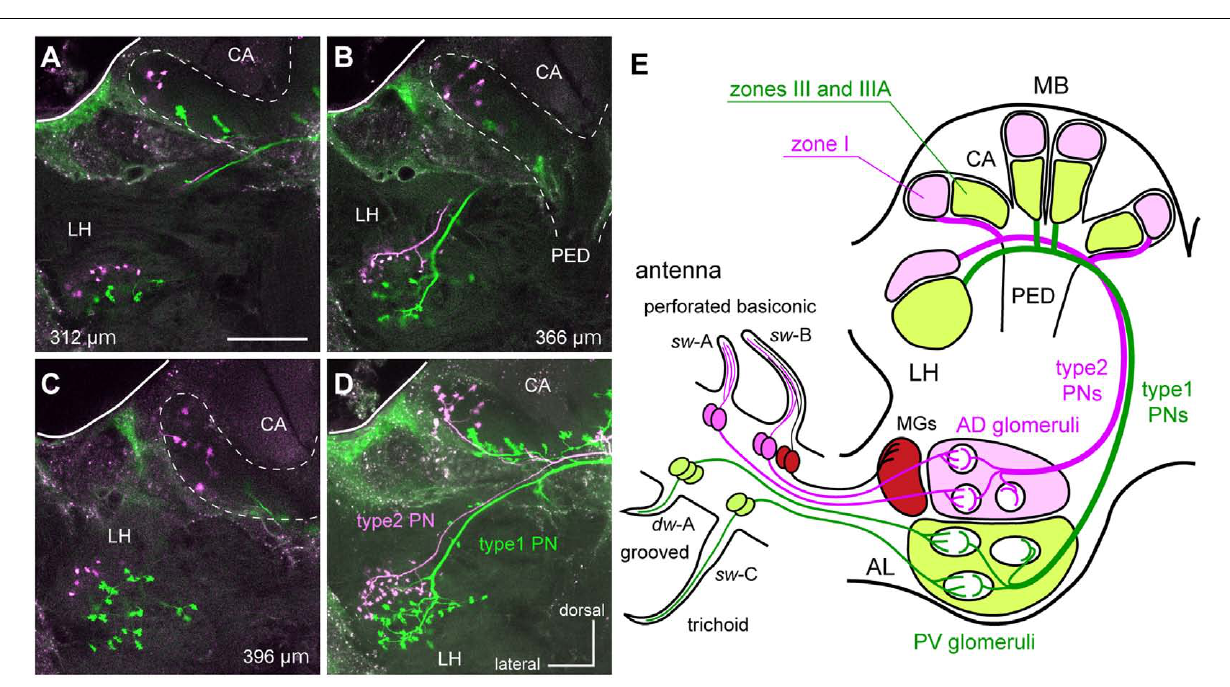
FIGURE 2 | The segregated parallel pathways from the periphery to higher brain centers in the cockroach brain. (A–D) A type1 PN (green) and a type2 PN (magenta) differentially labeled in the protocerebrum. Serial optical sections (A–C) and a stacked image (D) reveal that terminal regions of type1 PN are segregated from those of the type2 PN in the MB calyces (CA) and the LH. Depths of the serial optical images from anterior to posterior are indicated in each of panels (A–C) . Twenty-five serial optical images obtained every 4- µ m are stacked in (D) . Bar in (A) = 100 µ m. (E) Schematic drawing of parallel pathways from the periphery to higher brain center in the cockroach brain. OSNs in perforated basiconic sensilla ( single-walled A [ sw -A] and sw -B) selectively terminate in antero-dorsal group glomeruli (AD glomeruli), whereas those in trichoid sensilla ( sw- C) and grooved basiconic sensilla ( double-walled A [ dw -A]) projects to the postero-ventral group glomeruli (PV glomeruli: Watanabe et al., 2012b). Therefore, type1 PNs with dendrites in PV glomeruli and type2 PNs with dendrites in AD glomeruli form two segregated parallel pathways from the periphery to higher brain centers. Nomenclatures of MB calyces were described in previous articles (Mizunami et al., 1998; Strausfeld and Li, 1999a,b). MGs, macroglomeruli; PED,